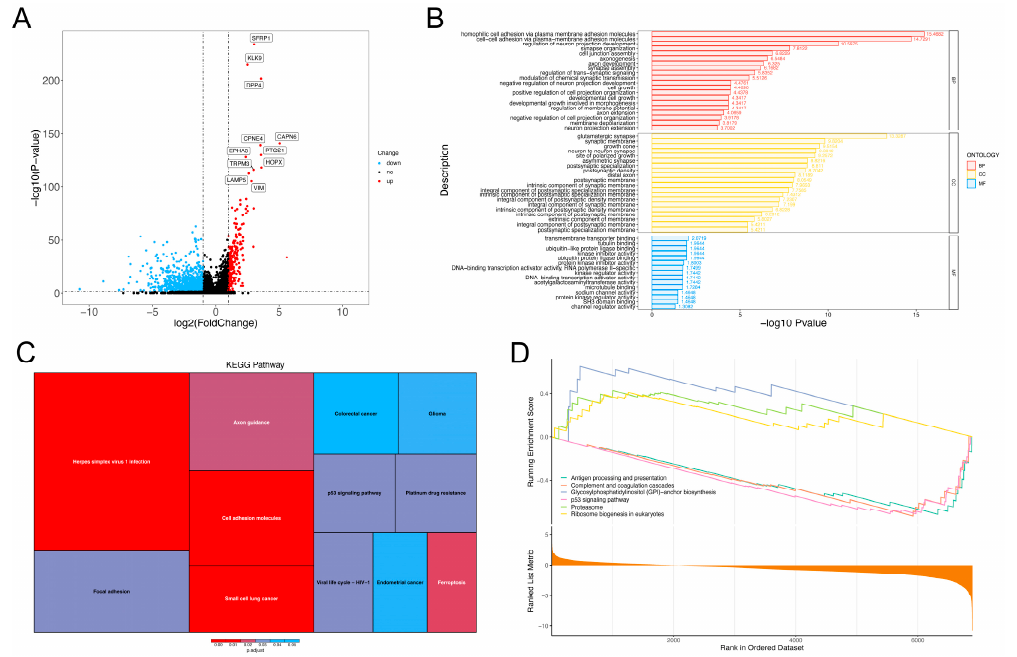
Figure 8. Biological functions of cell cluster 9 . ( A ) Volcano map of specific genes. X-axis is log2FC value, Y-axis is -log10 (corrected p value). Blue points are down-regulated genes, red points are up-regulated genes and black points are genes with no significant differences. ( B ) GO enrichment bar chart. ( C ) KEGG enrichment analysis. Colors represent the corrected p values and areas represent the number of genes enriched into the pathway. ( D ) GSEA enrichment line chart.